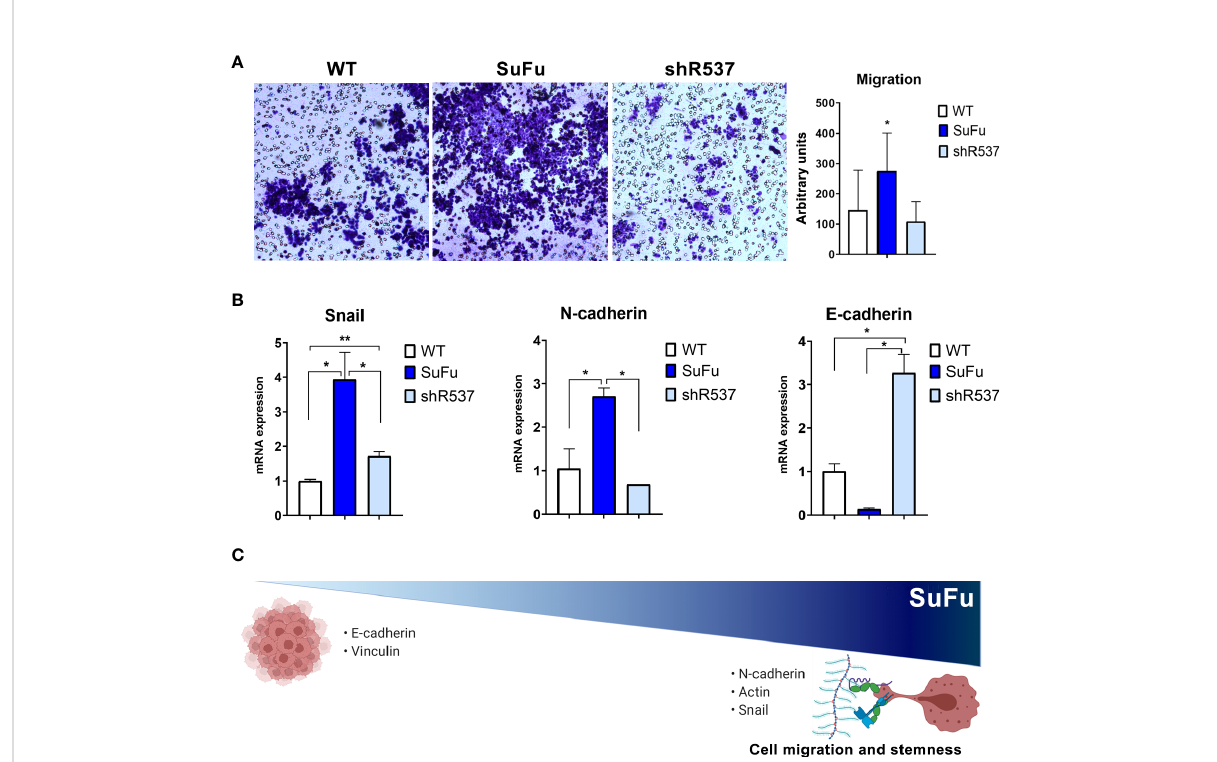
FIGURE 4 SuFu increases migration and mesenchymal phenotype. (A) Transwell migration assay. Relative migration of CSCs quanti fi ed with ImageJ. (B) Epithelial-to-mesenchymal transition expression genes. Data are shown as mean ± S.D. and are representative of two independent experiments. (C) Representative image of SuFu involvement in EMT. P-values were calculated based on the two-tailed two-sample t test. *P < 0.05 and **P <